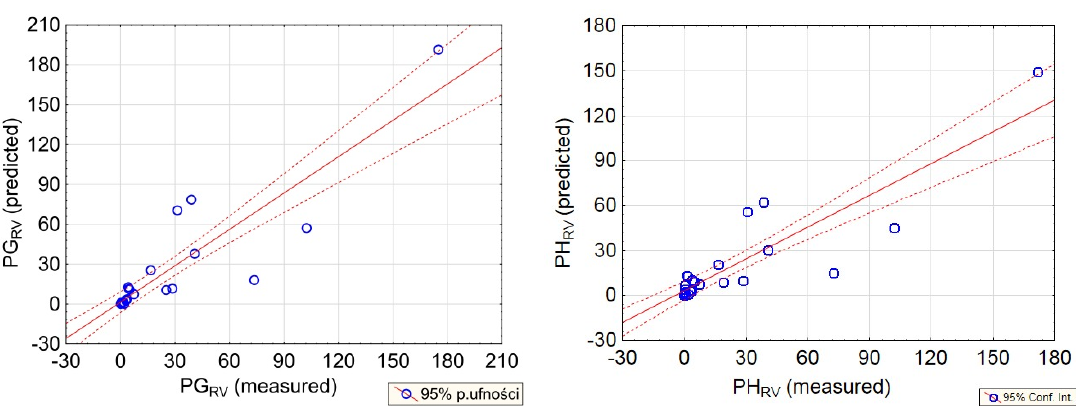
Figure 16. Regression plots for predicted vs. observed values of PGRV- left , and PHRV- right , at the Rudna-I shaft.